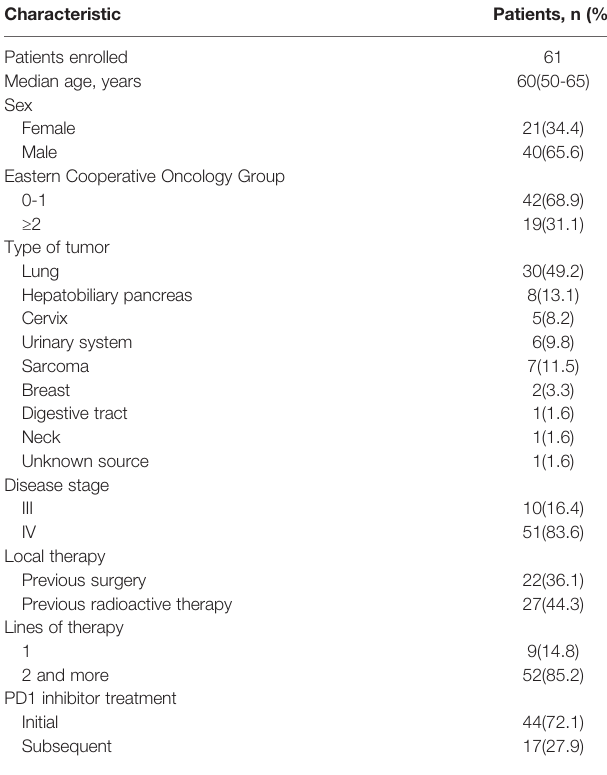
TABLE 1 | Patient demographic information and baseline